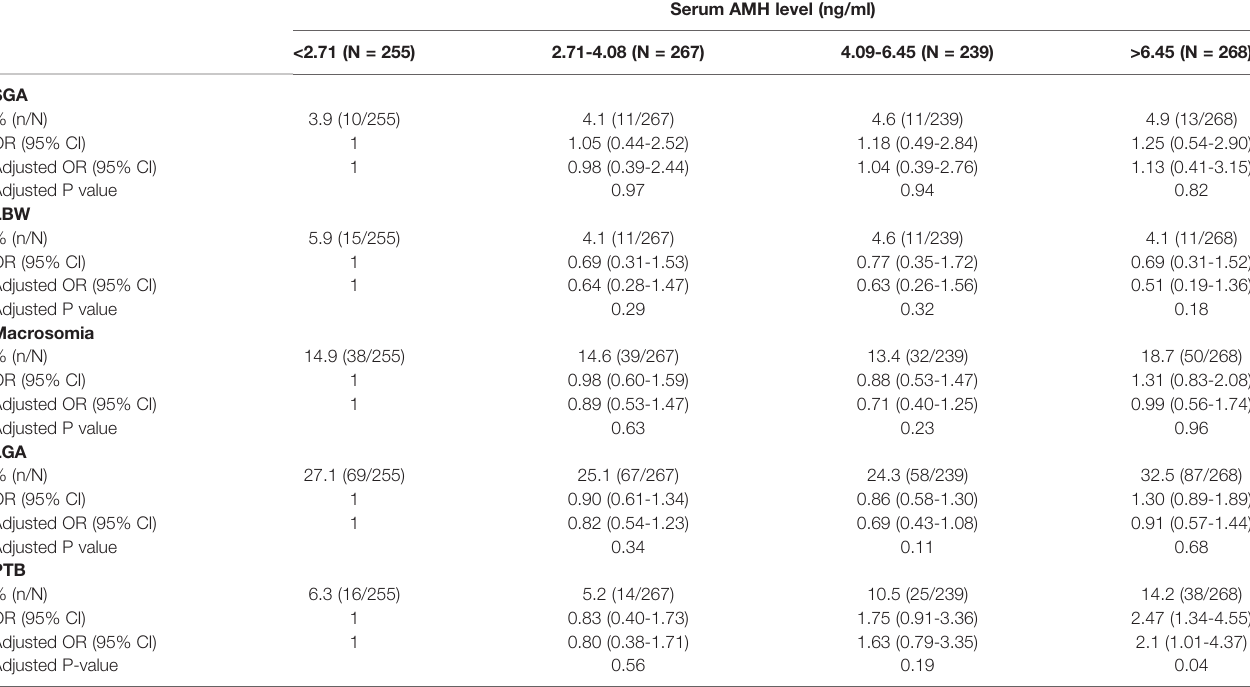
TABLE 3 | Neonatal outcomes among patients with PCOS and a BMI ≥ 24 kg/m 2 among the